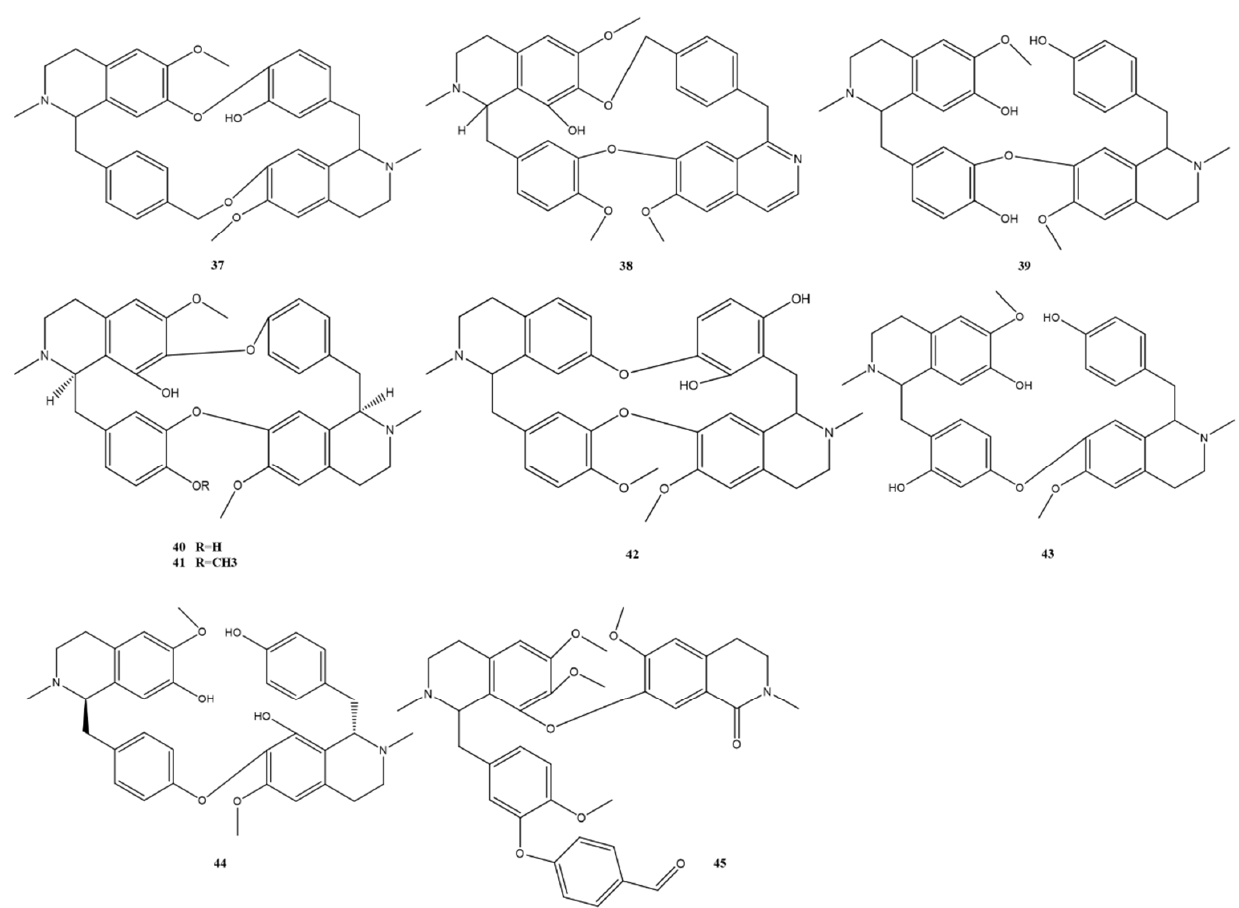
Figure 3. Bisbenzylisoquinoline alkaloids (structural skeleton II) in M. Rhizoma.